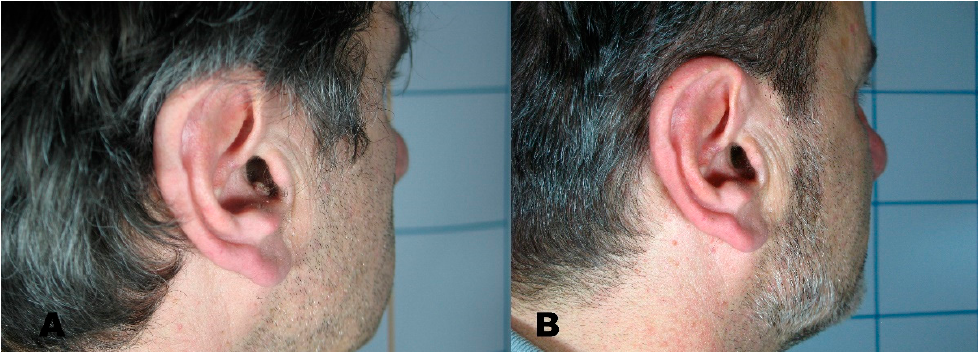
Figure 5. ( A ) Ear wart before treatment, ( B ) Region after removal with Erbium laser.